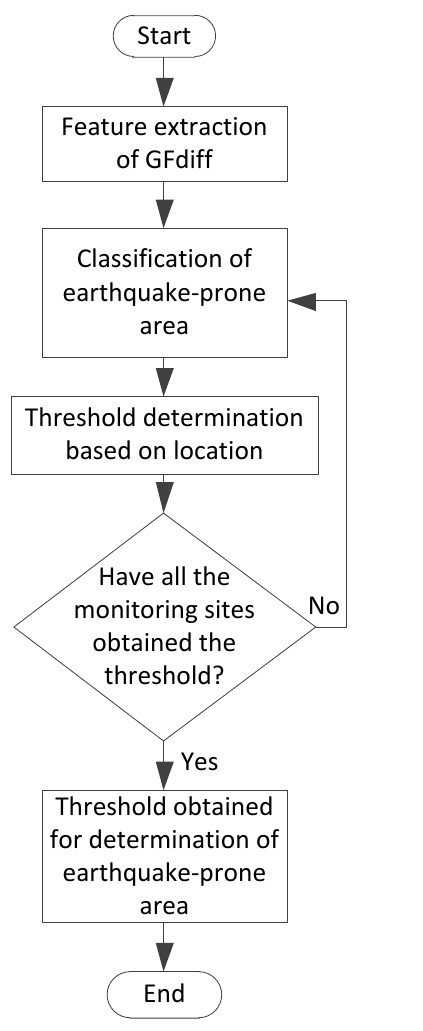
Fig.1. Location of the monitoring sites PYR (A), ATH (B), and HIO (C) (Thanassoulas, C., 2007).